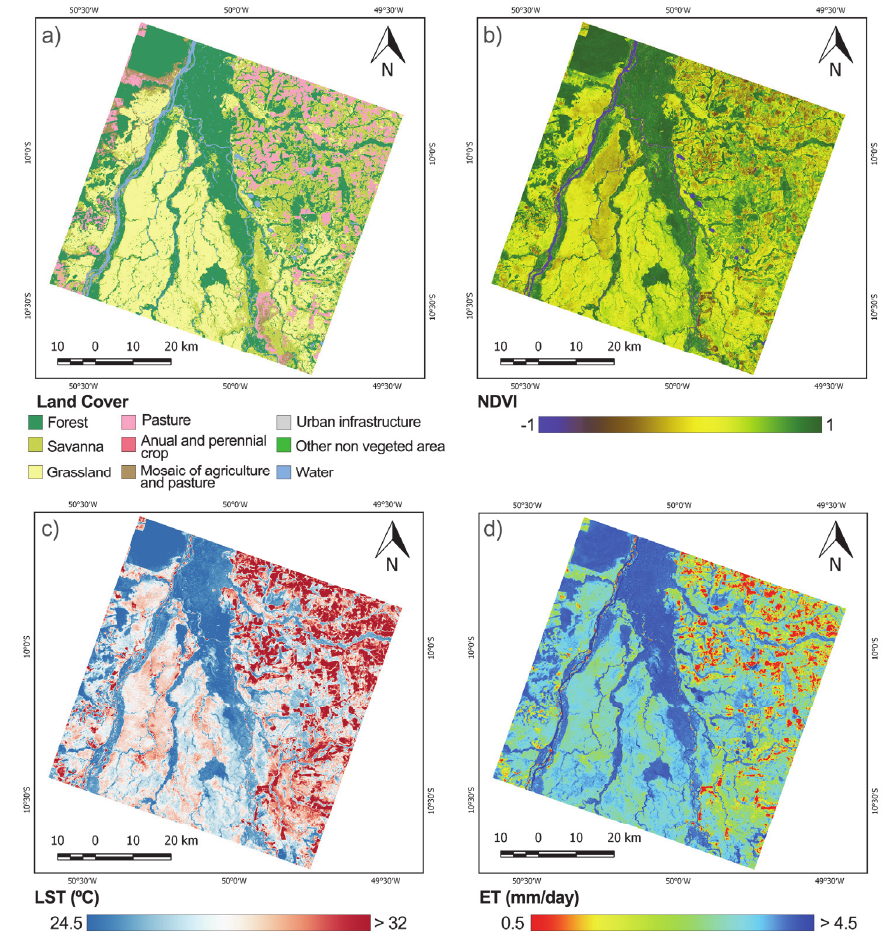
Figure 6. Spatial patterns of land cover ( a ) and the dry season average of vegetation index ( NDVI ) ( b ), surface temperature ( T s ) ( c ), and daily evapotranspiration ( ET ) ( d ) in the study area for the year 2004 DOY 200.